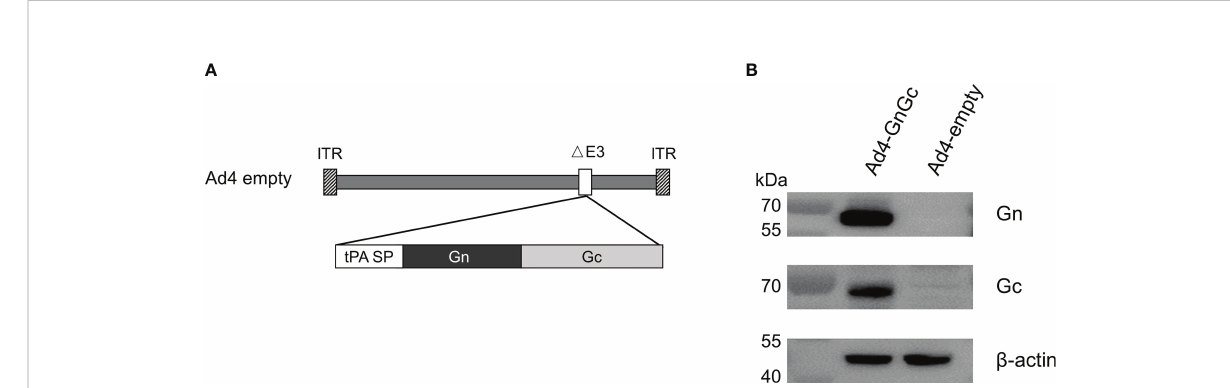
FIGURE 1 Construction and characterization of the RVFV vaccine Ad4-GnGc. (A) Schematic of the Ad4-GnGc vaccine expressing the RVFV glycoproteins Gn and Gc. (B) The expression of the Gn and Gc proteins in Vero E6 cells. Vero E6 cells were infected with Ad4-GnGc or Ad4-empty at a multiplicity of infection (MOI) of 10, and western blotting was performed 48 h after infection. ITR, inverted terminal repeat; tPA SP, tissue plasminogen activator signal